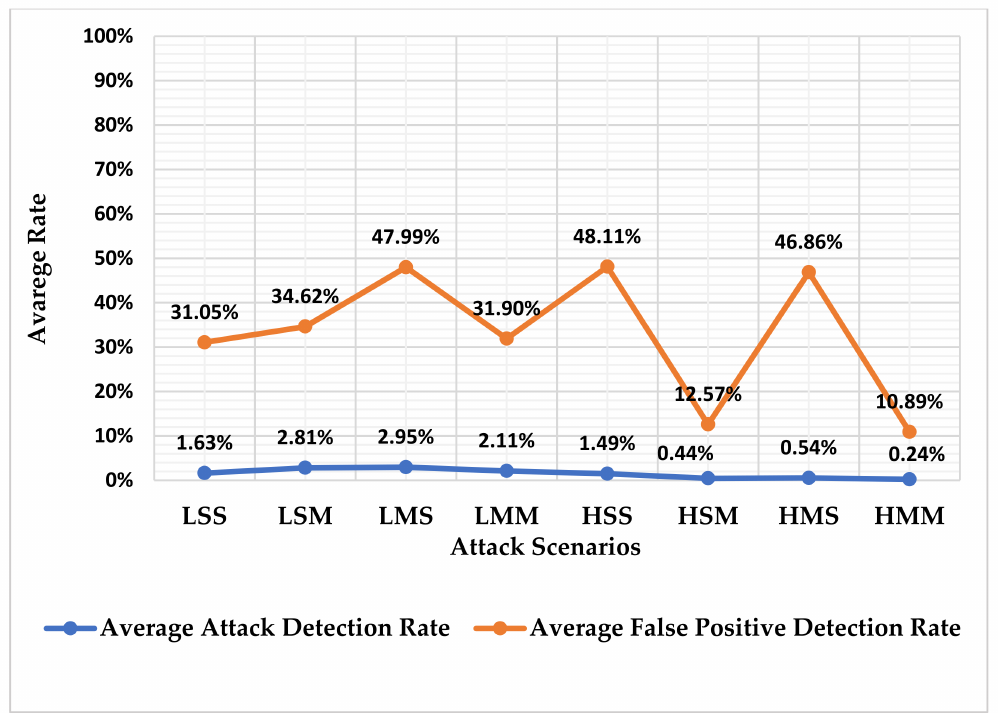
Figure 8. Average enhancement of proposed approach compared with information theory-based method using all simulation